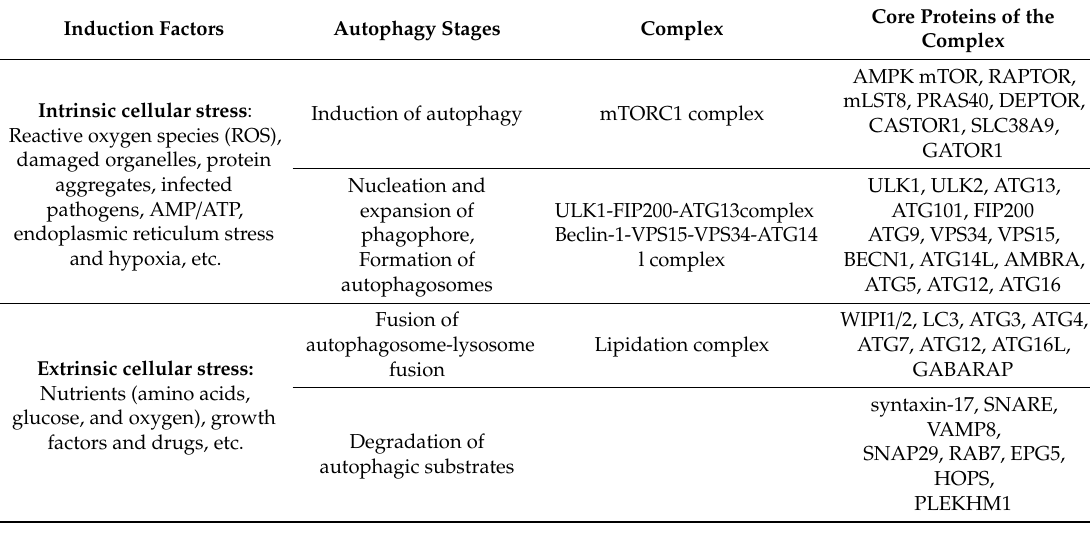
Table 2. Induction factors, important autophagy-related proteins, and their relevance to di ff erent stages of autophagy in mammalian cells [73,87,89,91–94].